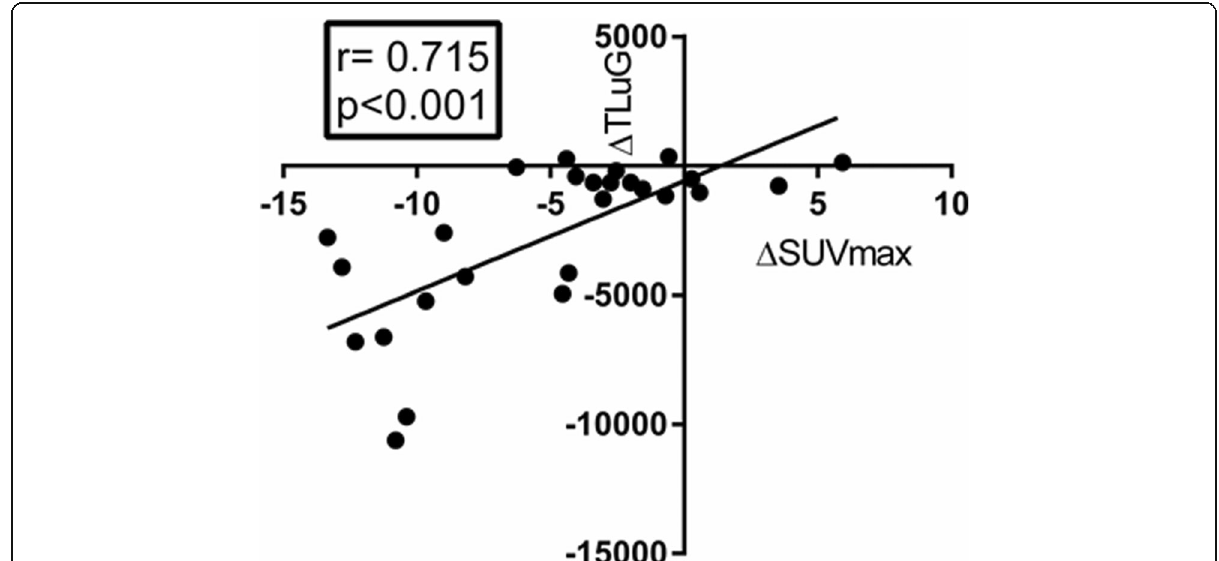
Fig. 2 Correlation of the change in SUVmax and